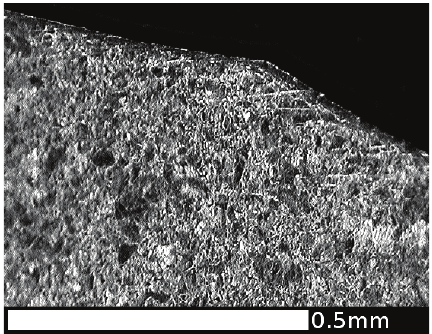
Figure 11: OM image of microstructure on the flange tip (A); this region does not contact the rails, and the surface shape retains the machining marks from the last turning on the lathe. There is no obvious shearing of the